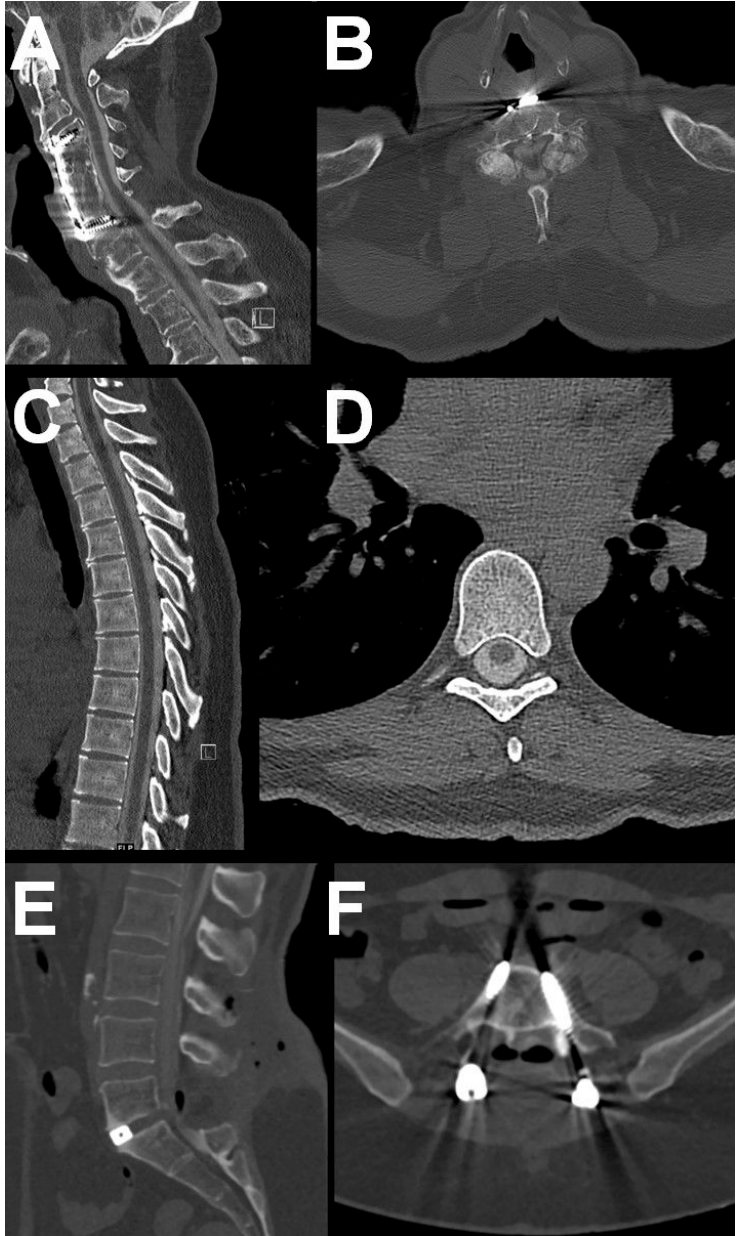
Figure 2. Image examples of CT myelography (CTM) of specific parts of the spine on the different CT scanners. ( A ) + ( B ): CTM on the SOMATOM Definition Flash of the cervical spine of a 79-year-old patient after ventral fusion C3–6 with impaired fine motor function of both hands with high-grade stenosis of neuroforamina C3 and C4 in the presence of marked hypertrophic spondylo-arthrosis. ( C ) + ( D ): Inconspicuous CTM on the SOMATOM Definition AS+ of the thoracic spine in a 41-year-old female patient with suspected thoracic CSF cyst. ( E ) + ( F ): CTM in dual-source technique on the SOMATOM Force of the lumbar spine of a 44-year-old female patient with a CSF leak at the level of L5 on the right after dorsal spondylosis and insertion of a disc cage. All scanners: Siemens Healthineers, Forchheim, Germany.